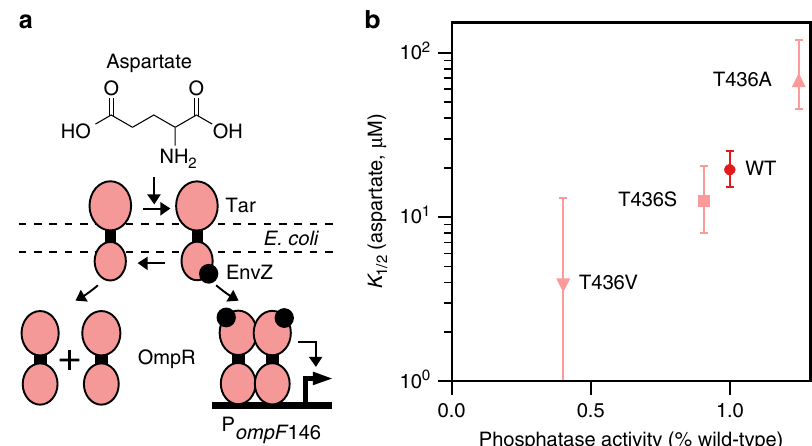
Fig. 4 TCS tuning an E. coli aspartate sensor. a The Taz-OmpR aspartate sensing TCS in E. coli . The Taz SK is composed of the Tar sensing domain fused to the EnvZ DhP and CA domains. Taz signals to OmpR which controls transcription from the P ompF output promoter. b The relationship between the phosphatase activity of the mutant as measured by Inouye and colleagues 36 and the K 1/2 fi t parameter from transfer function fi ts in Supplementary Fig. 5. Error bars are the 95% con fi dence interval of the K 1/2 fi